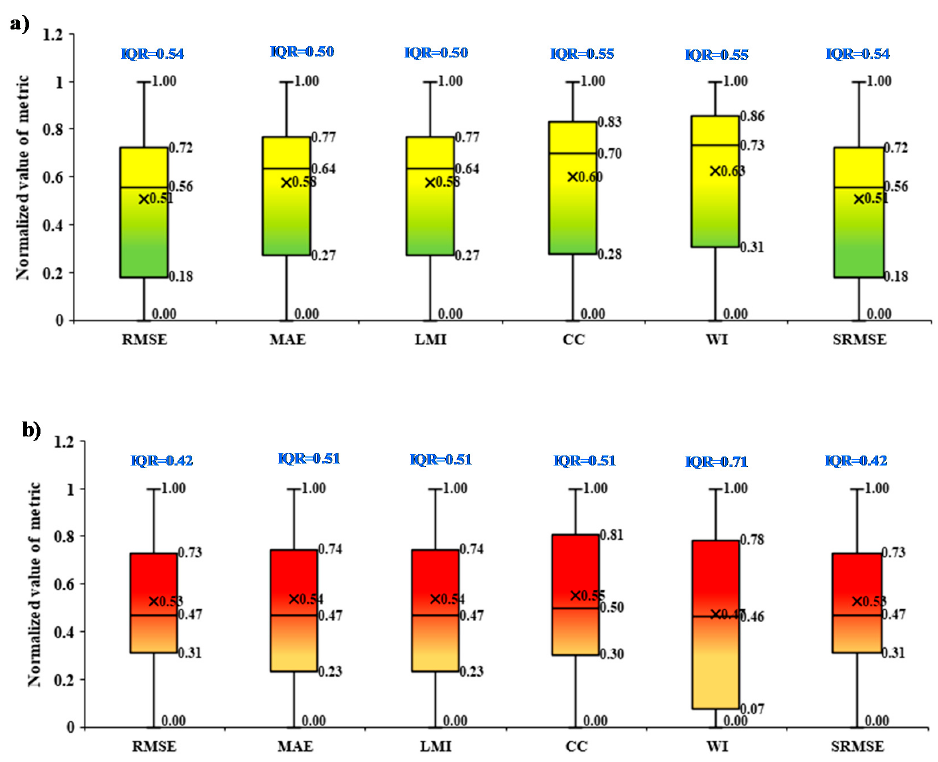
Figure 9. Boxplot of variable’s uncertainty based on performances index over ( a ) Training stage and ( b ) Testing